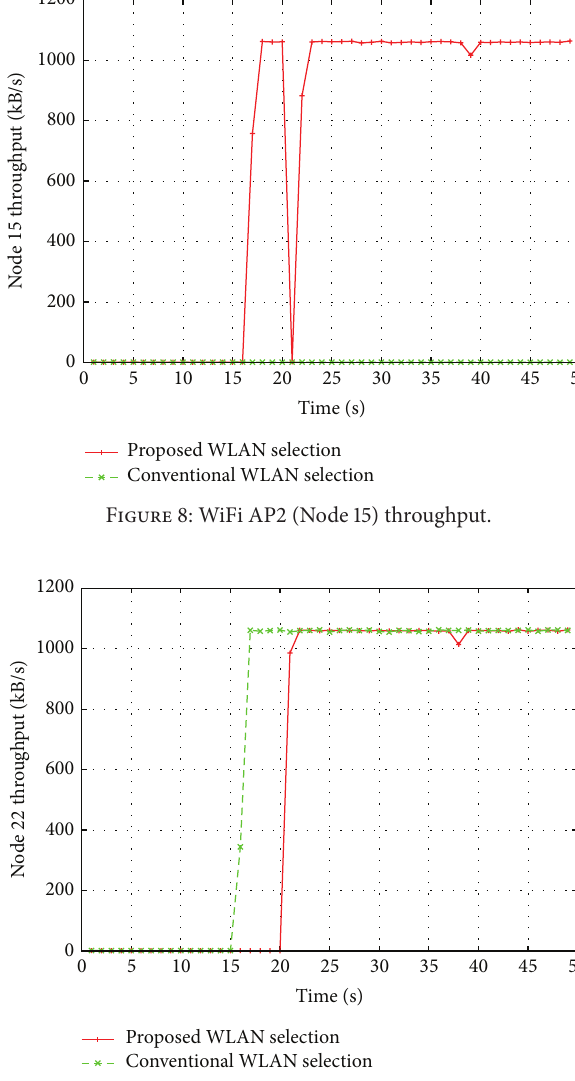
Figure 7: WiFi AP1 (Node 14) throughput.